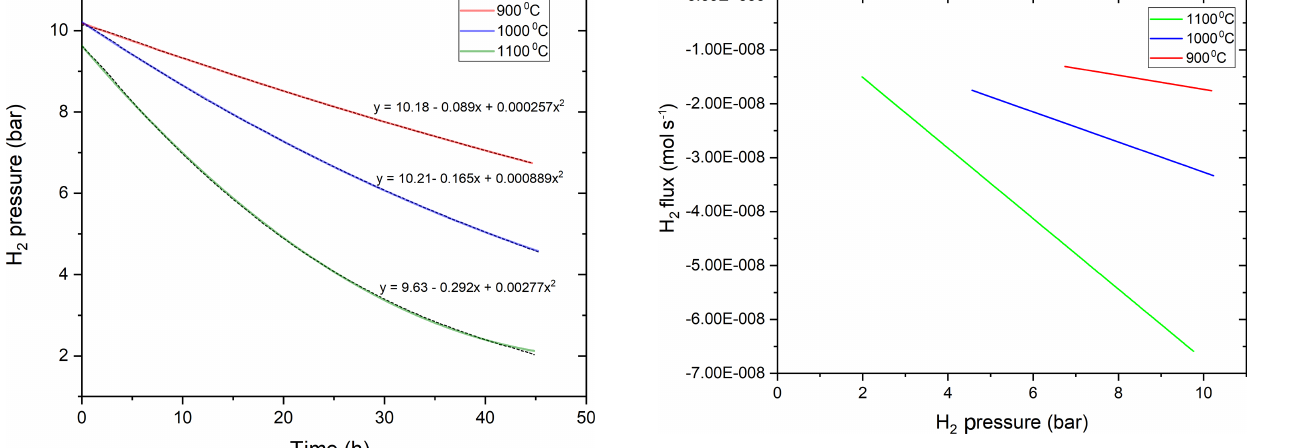
Figure 2. The time-dependent variation of the hydrogen pressure in the MHC vessel at different temperatures (900, 1000, 1100 ◦ C) due to diffusive hydrogen loss. The equation for the polynomial fit is given for each temperature. The original data are shown with short- dash black lines, whereas the colored lines represent the polynomial fits to the data.